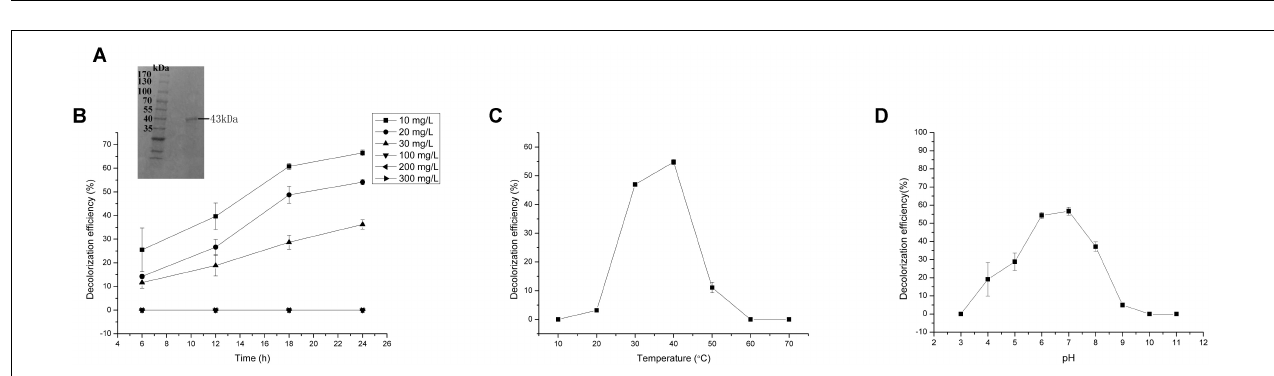
FIGURE 4 | Malachite green (MG) degradation characteristics of Mgv-rLACC. (A) SDS-PAGE result of Mgv-rLACC. (B) The effect of MG concentration on the MG decolorization efficiency of Mgv-rLACC. (C) The effect of temperature on the MG decolorization efficiency of Mgv-rLACC. (D) The effect of pH on the MG decolorization efficiency of Mgv-rLACC.